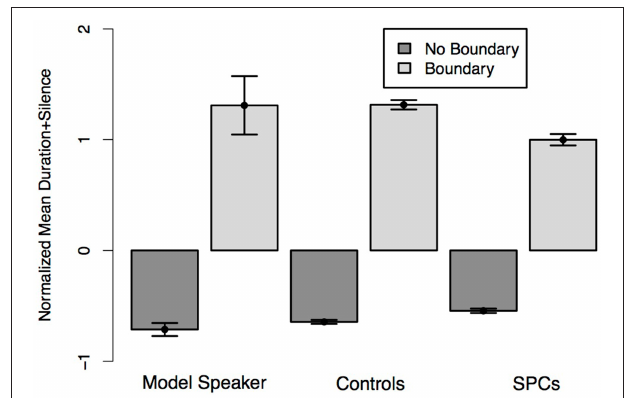
FIGURE 6 | Normalized average duration plus silence of words preceding hypothesized boundary locations and non-boundary locations in the Relative Clause sentences as produced by the Model Speaker, Controls, and SPCs. Error bars represent standard